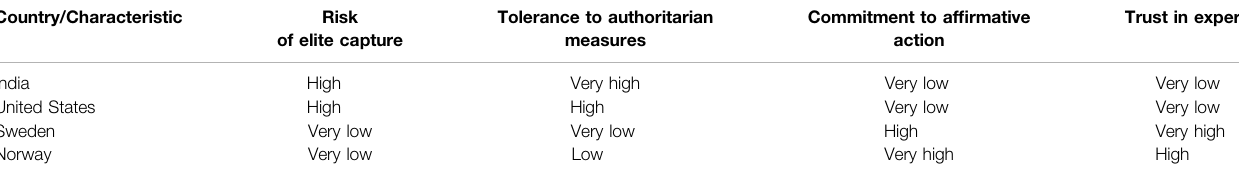
TABLE 6 | Revised ranking of hypothesized propensities for four state characteristics by country.